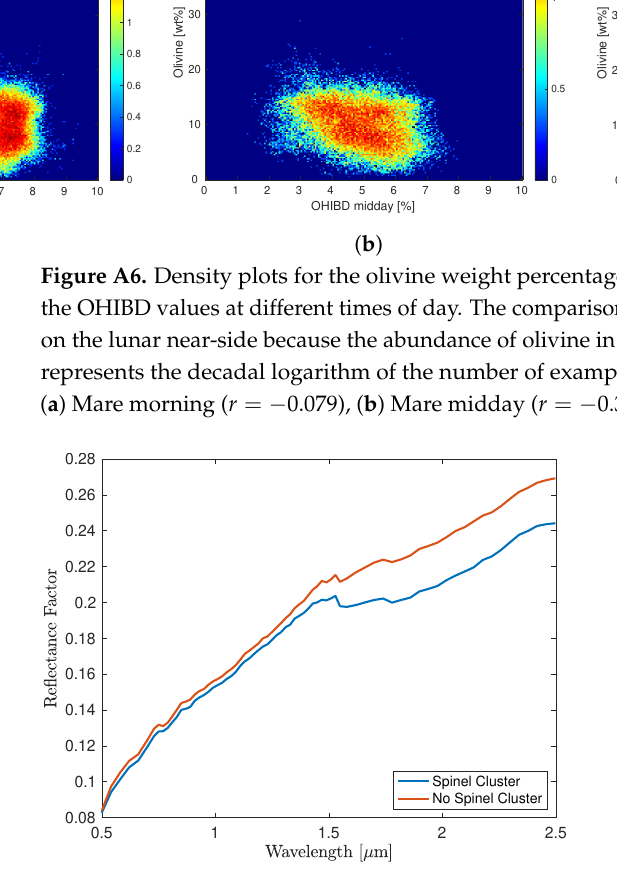
Figure A7. Mean spectra for the pixels with an NLBD value above 0.3 (blue curve) and below 0.3 (red curve) representing the spinel and no-spinel clusters, respectively (see Figure 11). These spectra are taken from the Theophilus crater region of